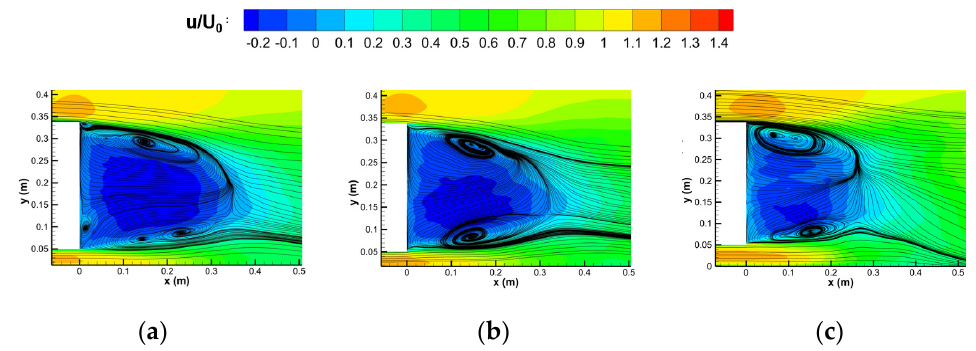
Figure 17. Time-averaged streamlines in the behind of the model, on the symmetry plane with a steady blowing jet at different jet angles. ( a ) β = 30 ◦ ; ( b ) β = 60 ◦ ; ( c ) β = 90 ◦ .